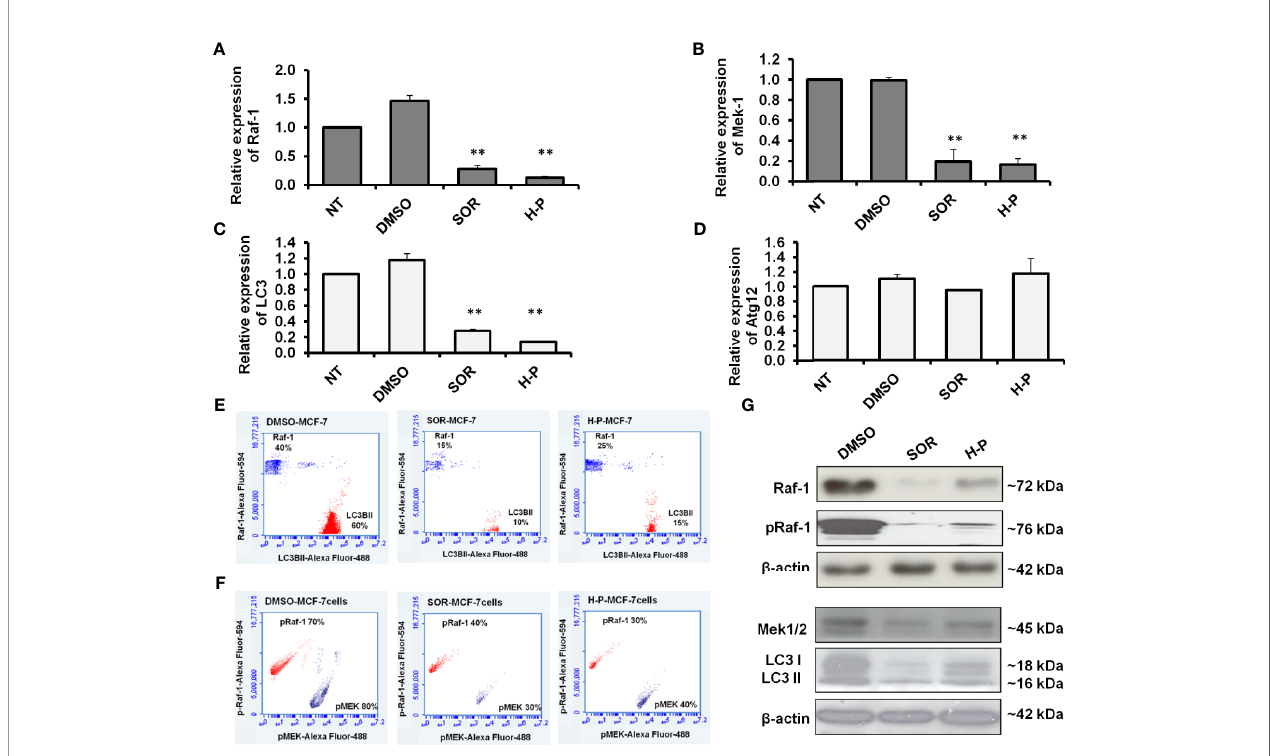
FIGURE 2 | Quanti fi cation of Raf-1, MEK1/2, LC3B, and ATG12 expression in SOR and H-P-treated cells. (A, B) Steady-state mRNA of Raf-1 and MEK1 indicated by the fold change in MCF-7 cells that were subjected to SOR or H-P extract in comparison with control-treated cells, n = 3. (C, D) Steady-state mRNA of autophagy-related LC3B and Atg12 indicated by the fold change in MCF-7 cells treated with SOR or H-P extract in comparison with control-treated cells, n = 3. Levels of GAPDH – mRNA were used as an internal control. Error bars indicate the SD of three independent experiments. (E) Quanti fi cation analysis of protein pro fi le of both total Raf-1 and lipidated LC3B in treated MCF-7 cells indicated by fl ow cytometry and compared to DMSO-treated cells. (F) Quanti fi cation analysis of kinetic protein pro fi le of pRaf-1 and pMEK in MCF-7 cells that were subjected to SOR or H-P indicated by fl ow cytometry and compared to DMSO-treated cells. (G) Immunoblotting investigation of total Raf-1, pRaf-1 Mek1/2, and LC3B proteins in pretreated MCF-7 cells using WesternBreeze Chromogenic Kit. b -Actin served as a loading control. Data are representative of three independent experiments. A Student ’ s two-tailed t-test was used for signi fi cance analysis of cycle threshold (Ct) values. ** p ≤